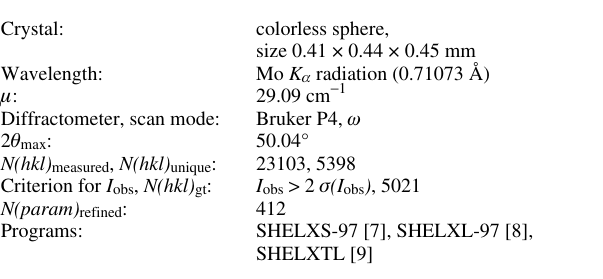
Table 1. Data collection and handling.